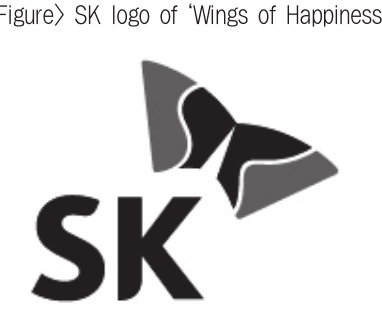
<Figure> SK logo of ‘Wings of